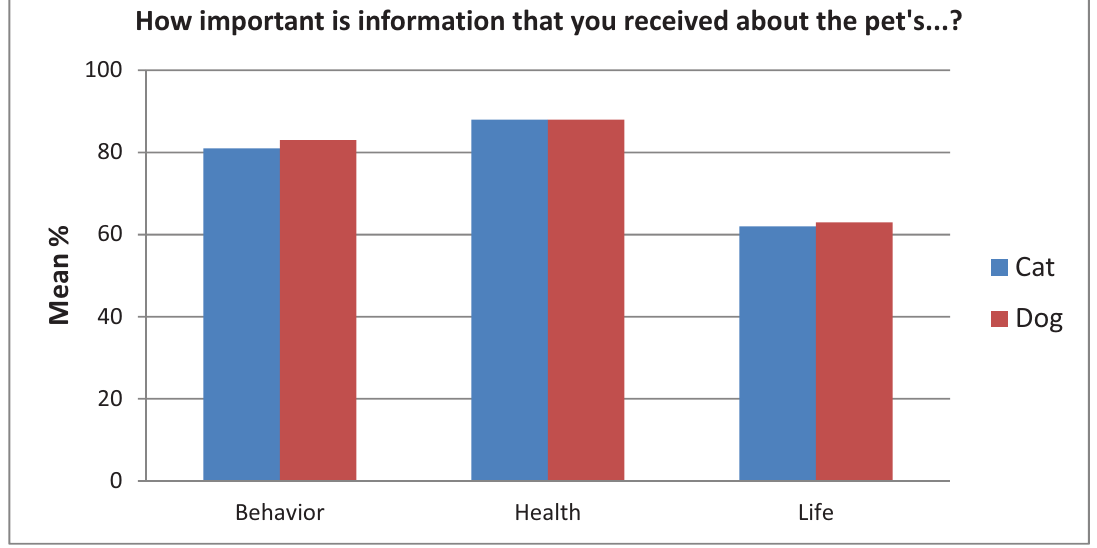
Figure 8. The importance of behavior, health, or prior life experiences of the dog or